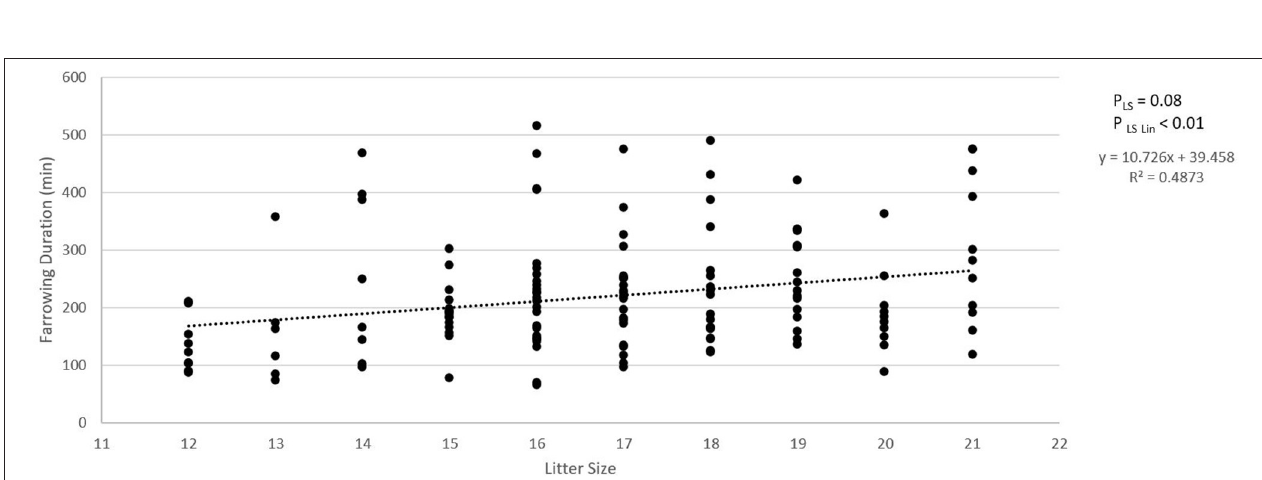
FIGURE 3 | Relationship between litter size and farrowing duration. Total duration of farrowing was defined as the time between the birth of the first and the last piglet in a litter. p LS is the p -value for the fixed effect of litter size. p LSLin is the p -value for the linear effect of litter size.